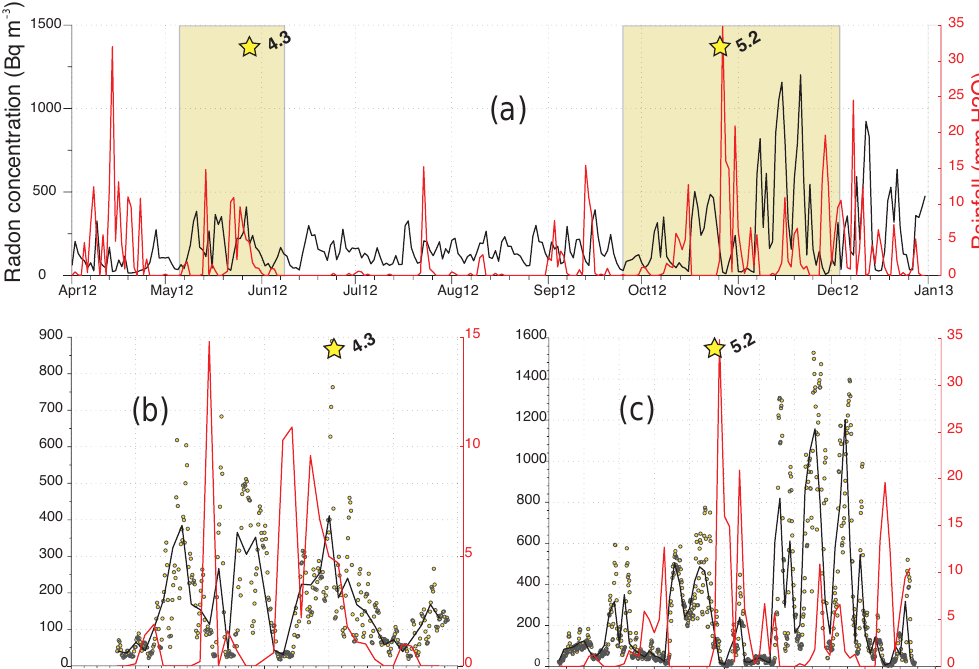
Figure 5. (a) Time series of daily moving-averaged radon concentration at MMN (black line) and of rainfall (red line) for the period between 1 April 2012 and 31 December 2012. Yellow stars represent the occurrences of the two main earthquakes of the sequence. (b) an enlarged view of the first yellow rectangle of (a) , from May to June 2012. Yellow dots represent radon concentration at MMN in (Bqm − 3 )/115min, while a black line shows the daily averaged concentration. Daily averaged rainfall levels are represented by a red line. (c) An enlarged view of the second yellow rectangle of (a) , from September to December 2012, as in panel (b)